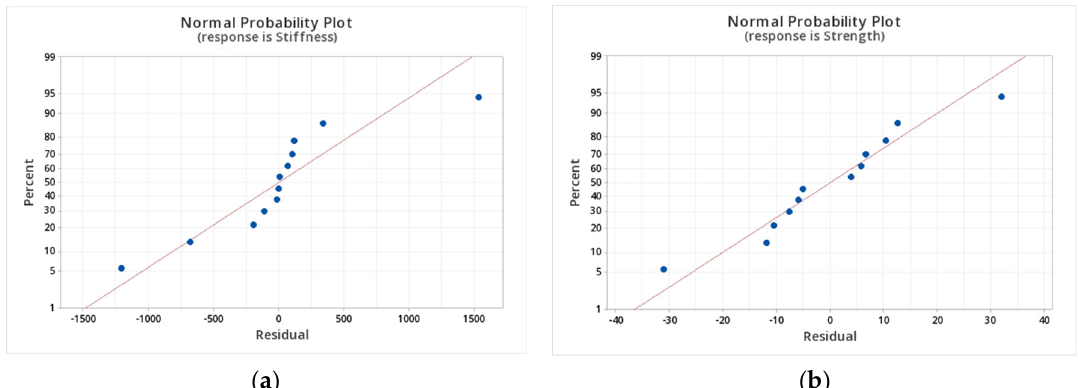
Figure 6. Normal residual plots for ( a ) stiffness and ( b ) strength.